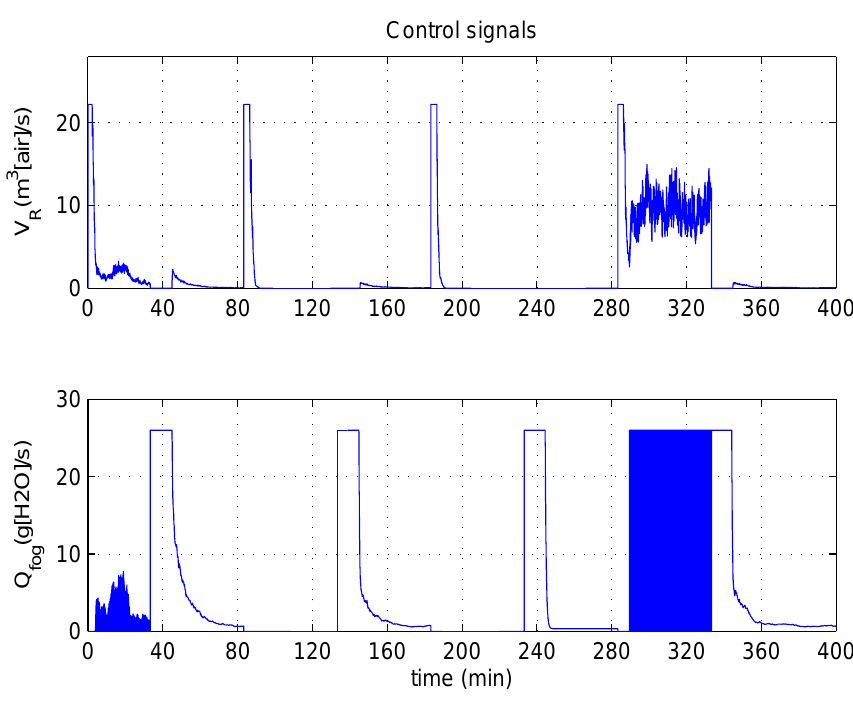
Figure 15. Variation of conventional PID control signals during the tuning process.